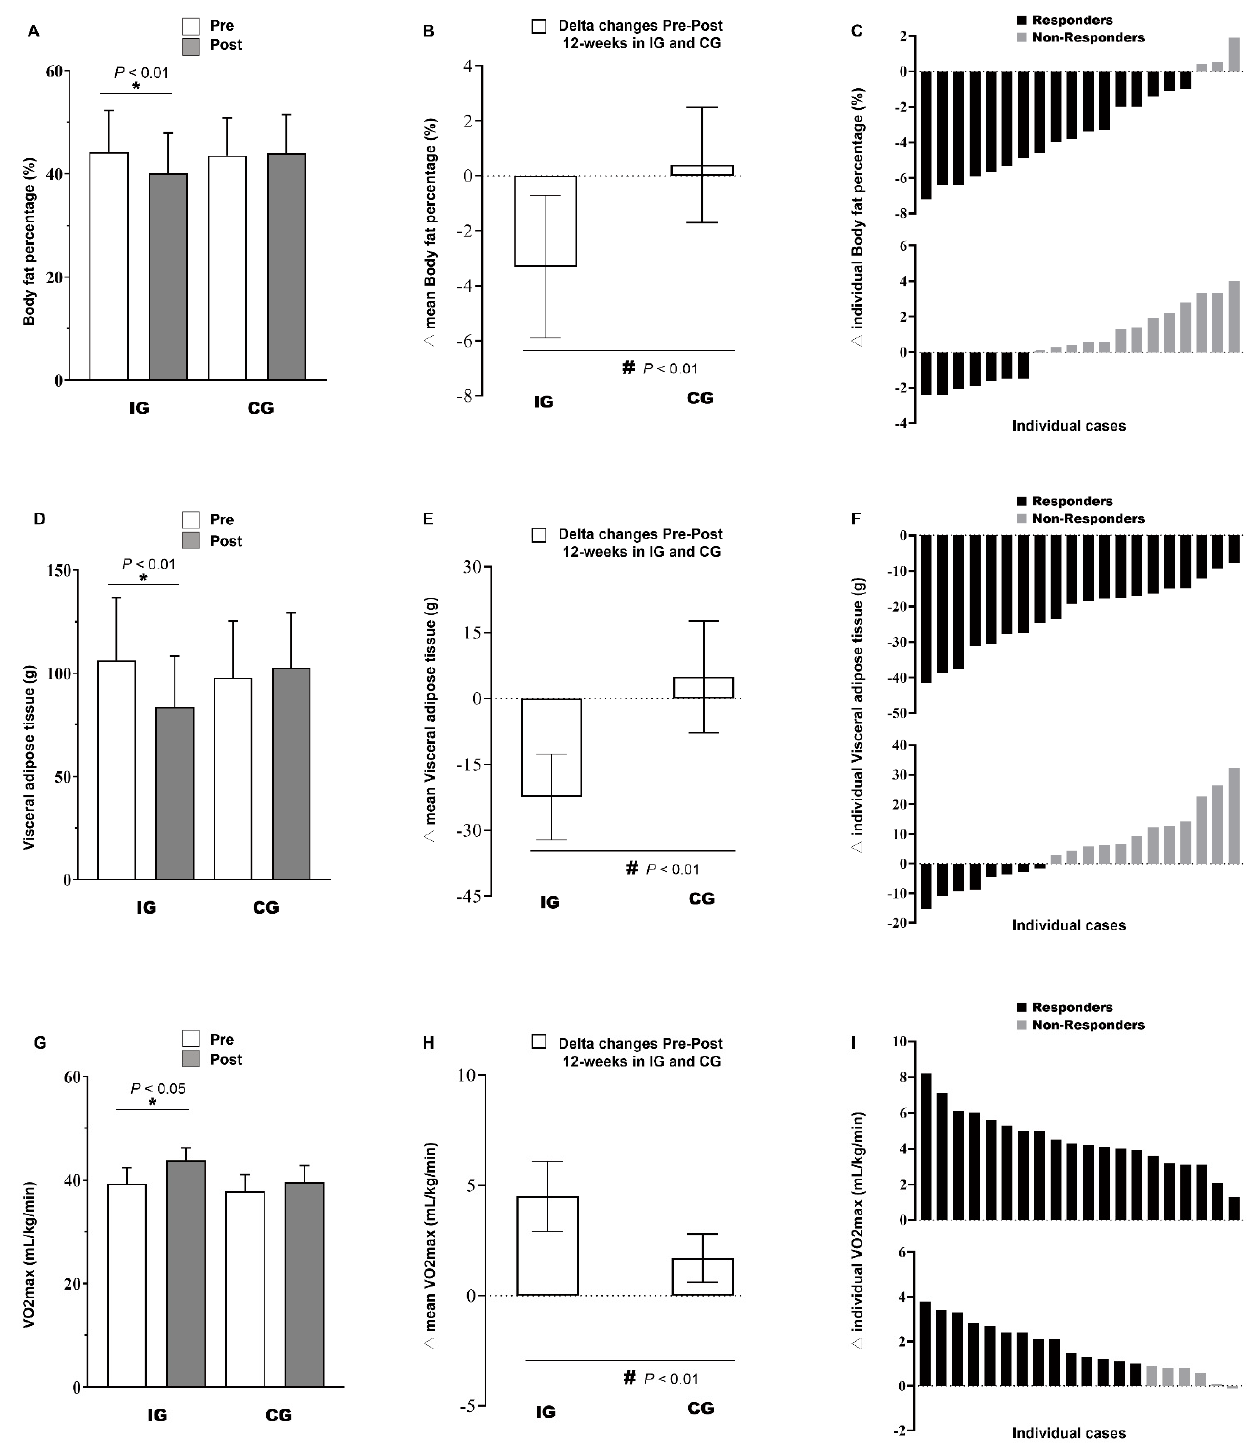
Figure 3. Pre-post changes ( A , D , G ), delta (mean) ( B , E , H ), and delta (individual) ( C , F , I ) of body fat percentage, visceral adipose tissue, and maximal oxygen uptake in children with obesity. * Denotes significant differences pre vs. post within group at level p < 0.05; # Denotes significant differences between IG vs. CG at level p < 0.05.